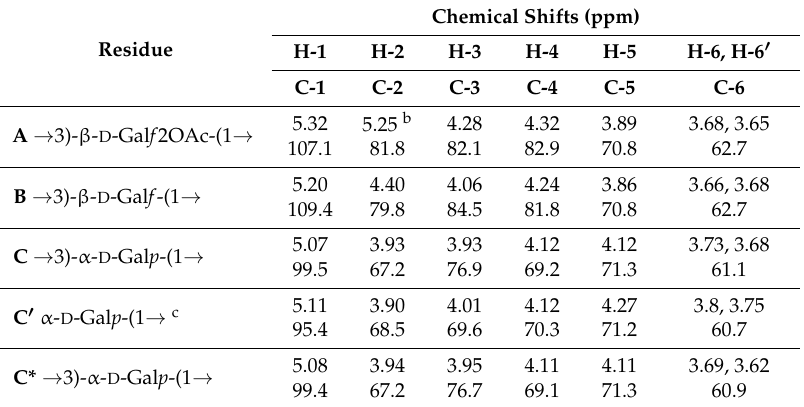
Table 1. 1 H and 13 C NMR chemical shifts of the O- specific polysaccharide of P. shigelloides strain CNCTC 78/89 a